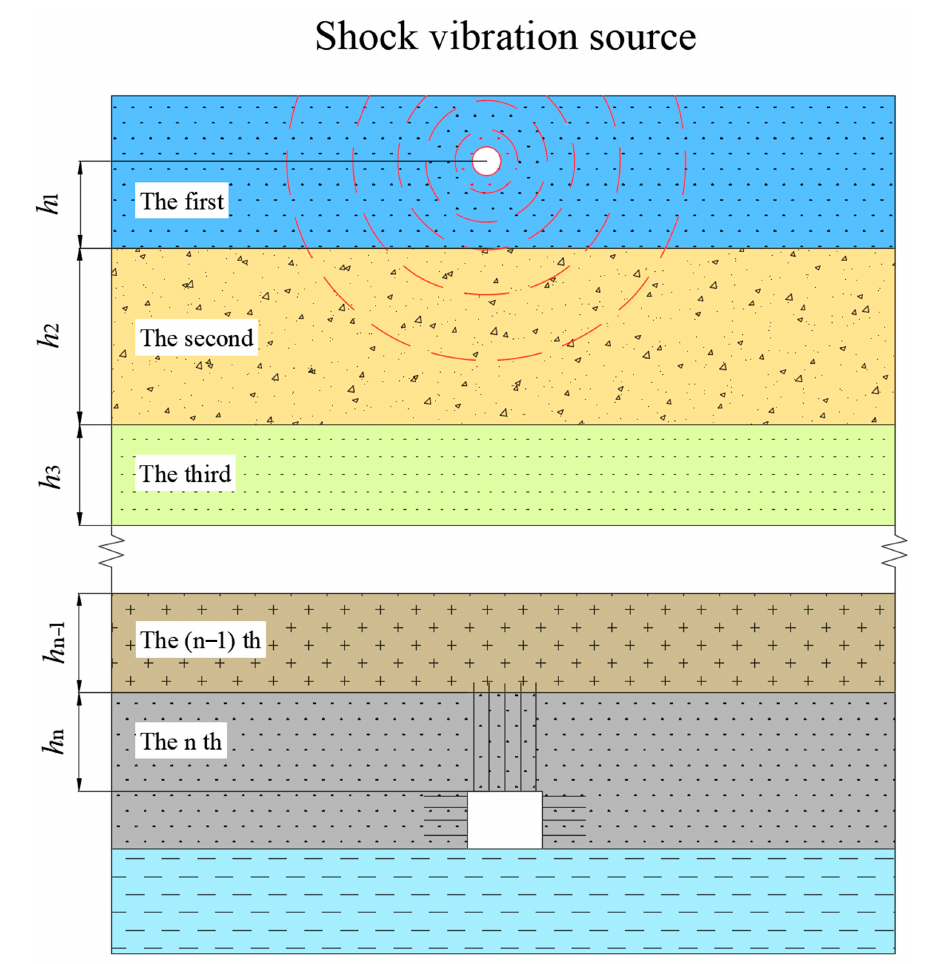
Figure 12. Mechanical modeling of shock wave attenuation through layers. Compared to large structures such as working faces and chambers, the size and projected area of the roadway section is very small. Simplifying the roadway section to a circular hole, the radial and tangential stresses ( σ r and σ θ ) at the center of the circle for a small hole of radius R in a uniform stress field, according to the theory of elastodynamics, are: